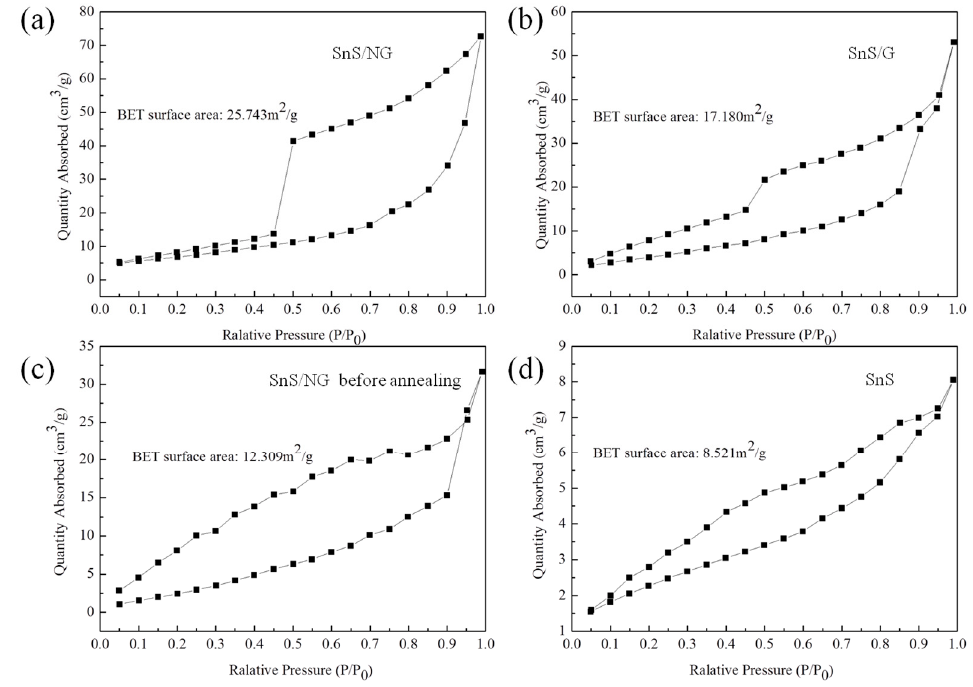
Figure 3. N 2 isotherms and calculated Brunauer–Emmett–Teller (BET) specific surface area of ( a ) SnS/NG, ( b ) SnS/G, ( c ) SnS/NG before annealing and ( d ) SnS.